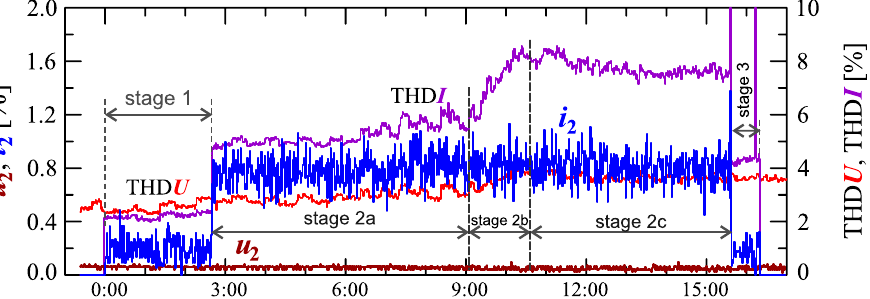
Figure 37. The characteristics of the voltage THD factor THD U = f ( t ) and current THD factor THD I = f ( t ) and the characteristics of the second harmonics of the current i 2 = f ( t ) and voltage u 2 = f ( t ) for Case V.